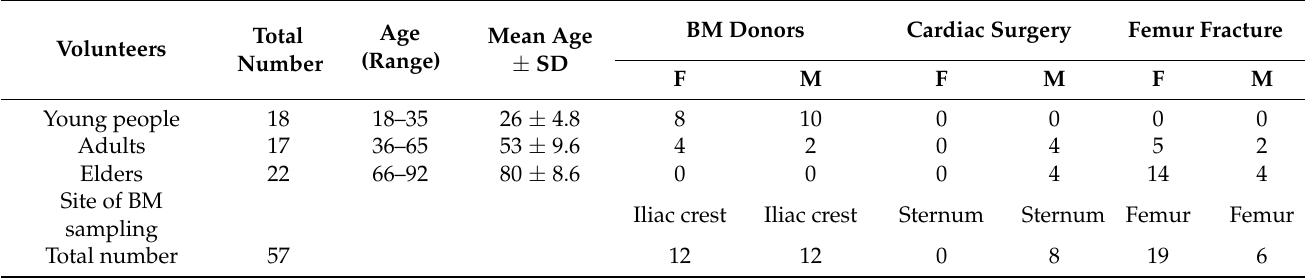
Table 1. Demographic and clinical features of BM donors and